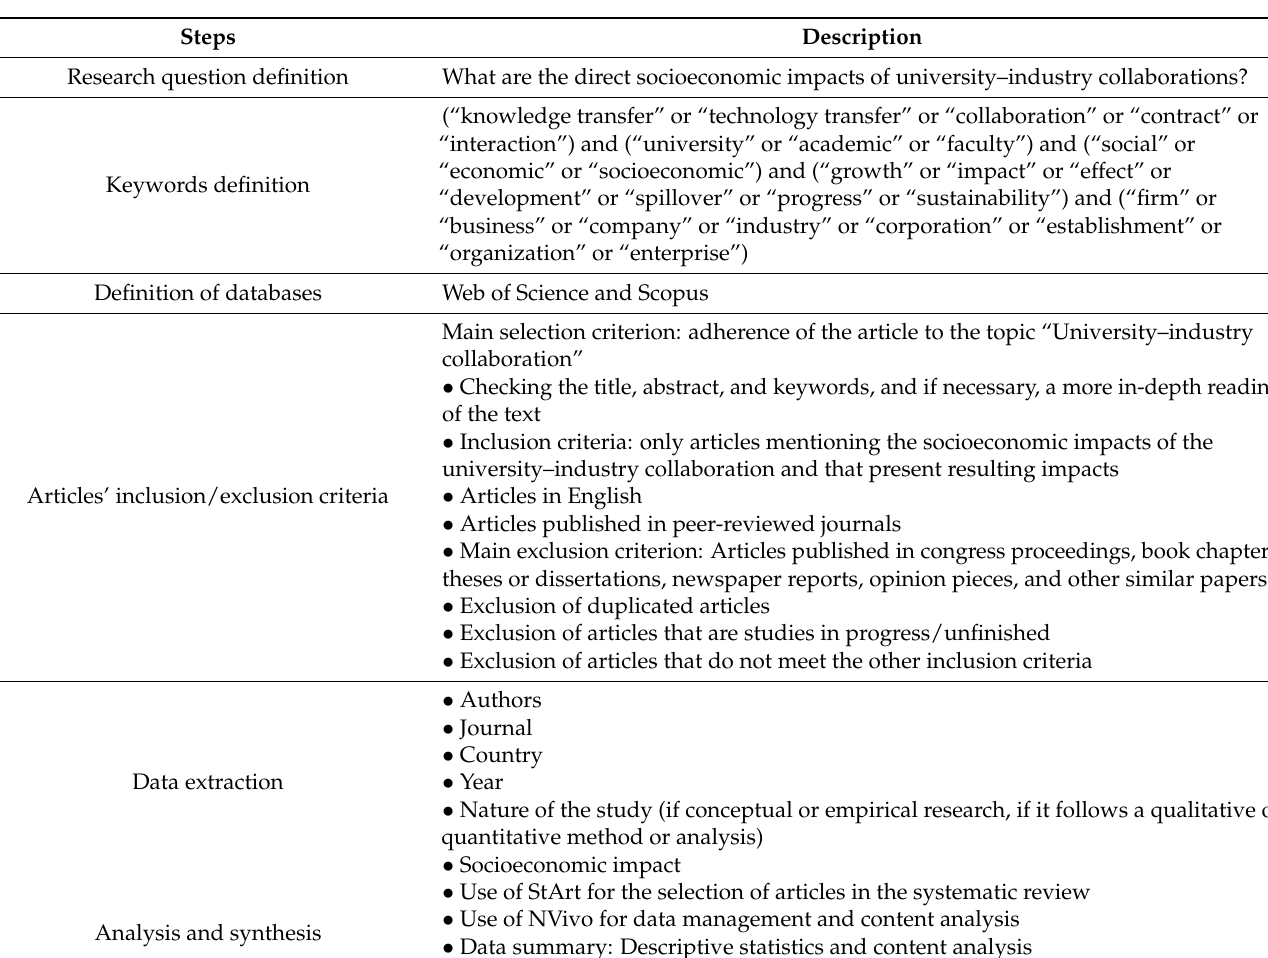
Table 1. Review protocol.